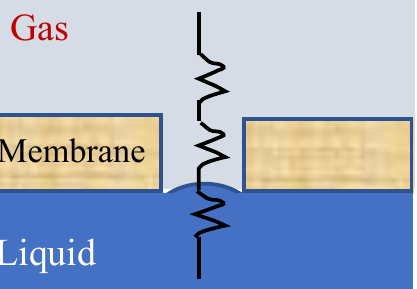
Figure 5. Sketch of mass transfer resistances in gas-liquid membrane contactors.